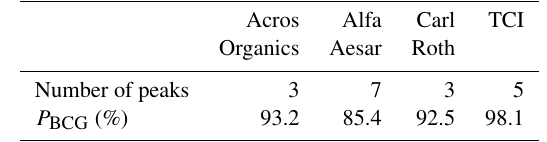
Table 3. Summary of analytical HPLC of purified BCG. Purified